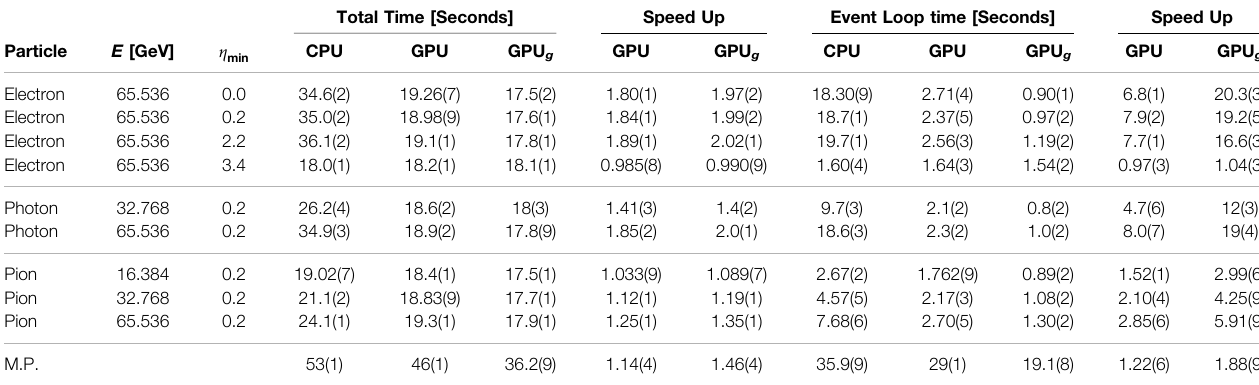
TABLE 1 | Execution time for the complete job and for only the event loop part of the job, for various input fi les. M.P. stands for multi-particle. GPU g is for GPU group simulation code. Numbers in the parentheses are the signi fi cant digits of the standard deviations. For example, 34.6(2) means 34 . 6 ± 0 . 2, while 53(1) is equivalent to 53 ±